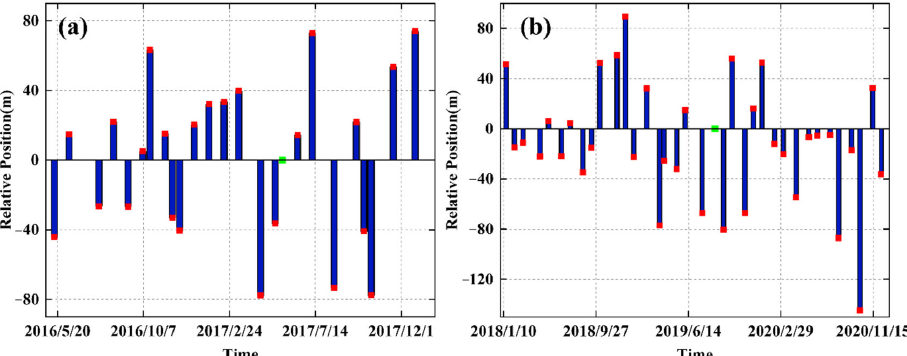
Figure 4. Time ‐ position of Sentinel ‐ 1A images. ( a ) The SAR images from May 2016 to December 2017; ( b ) SAR images from January 2018 to December 2020. Red and green square represent primary image and secondary images, respectively.